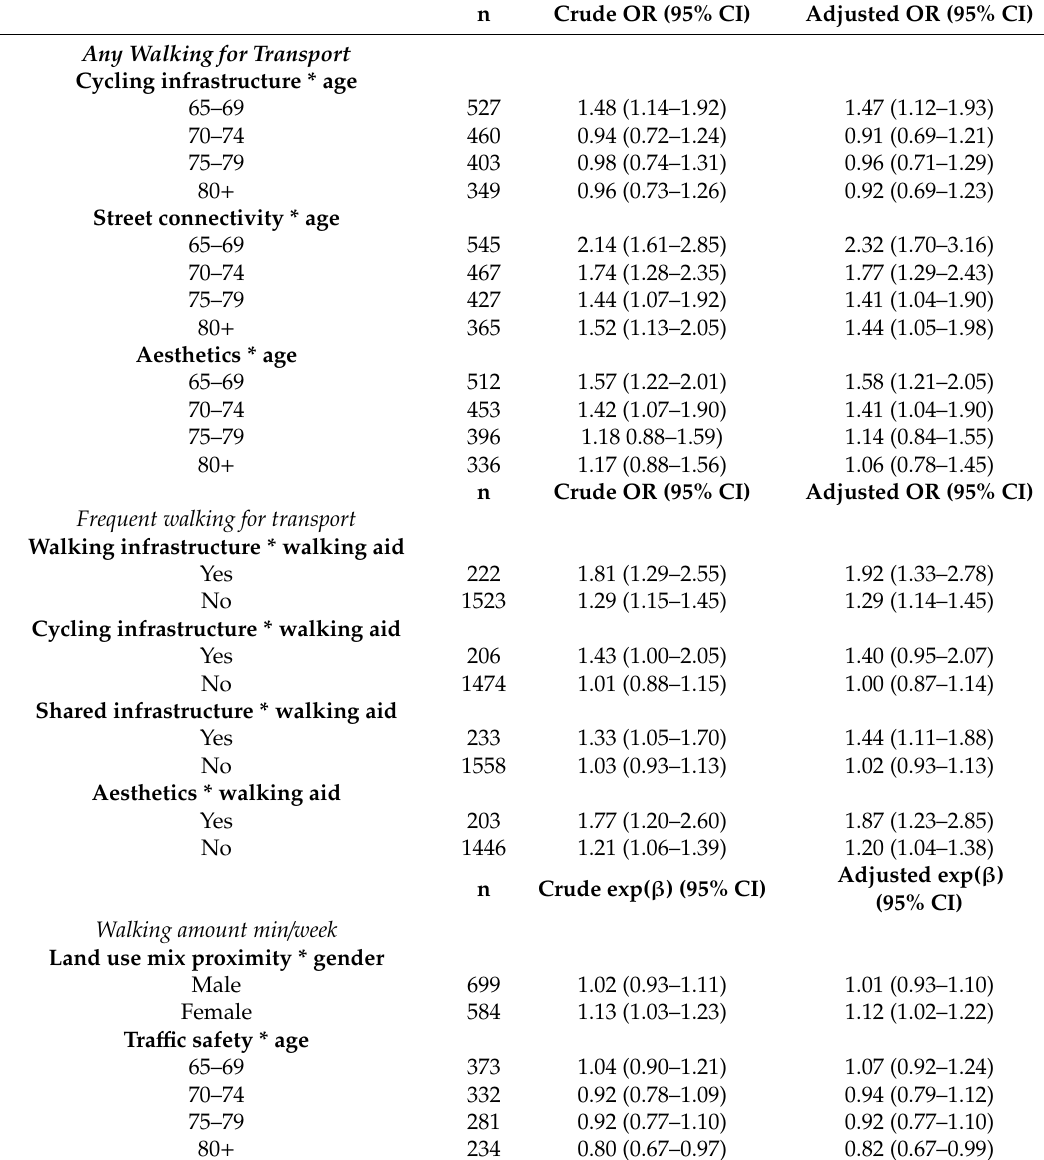
Table 4. E ff ect modification by gender, age, and use of a walking aid of the association of perceived environmental attributes with walking for